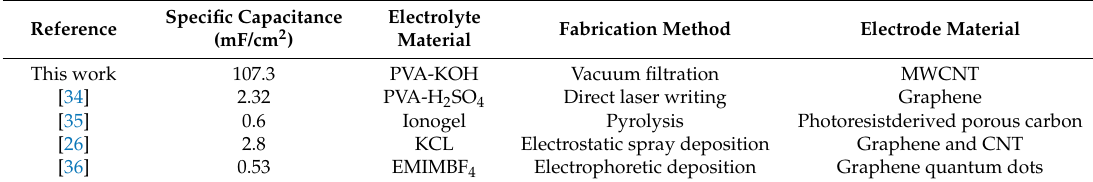
Table 3. Specific capacitances at different scan rates. PVA-KOH = Polyvinyl alcohol-potassium hydroxide. Reference